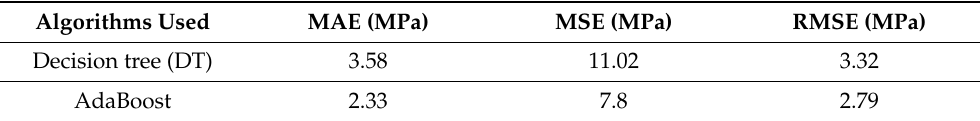
Table 5. Statistical checks for compressive strength.